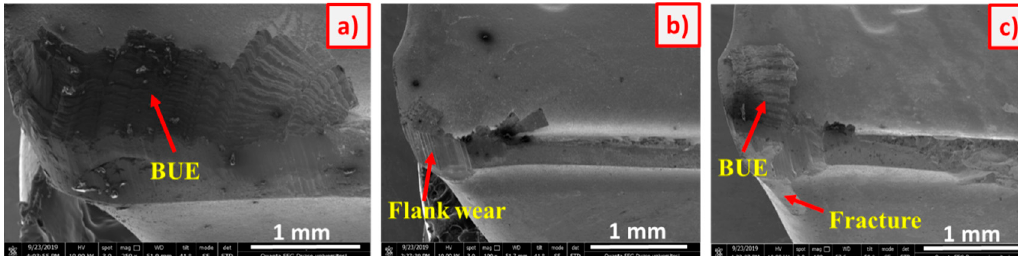
Figure 7. SEM image of built-up edge (BUE) ( a ), flank wear ( b ), and tool wear ( c ) that occurred on the cutting tool as a result of the milling of NiTi SMA under different machining parameters with the nose radius of 0.8 mm and at high feed rate (0.14 mm/tooth).